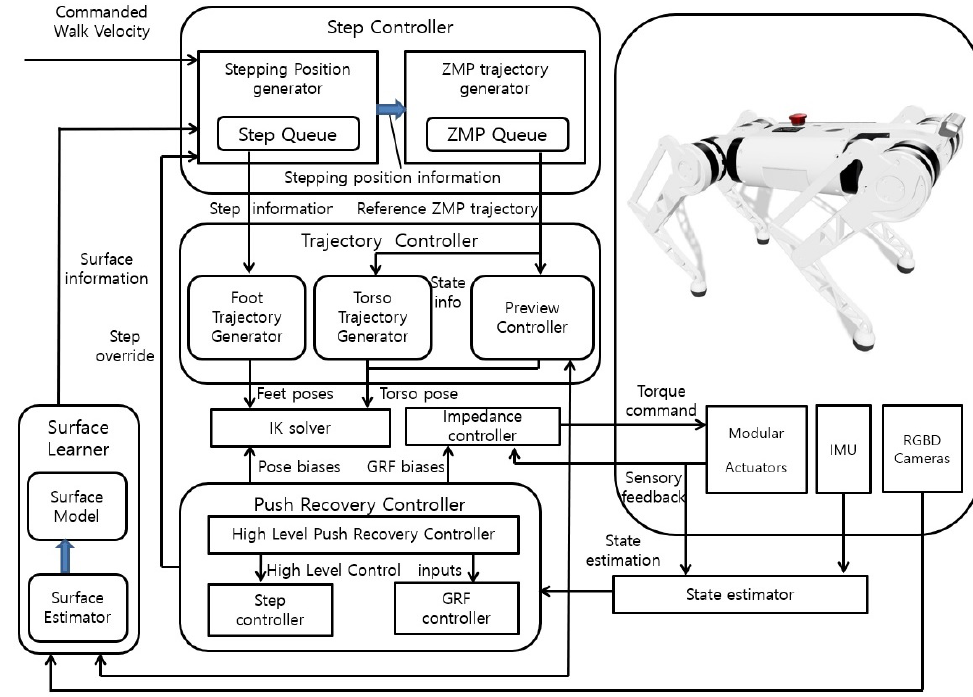
Figure 11. Motion controller architecture of